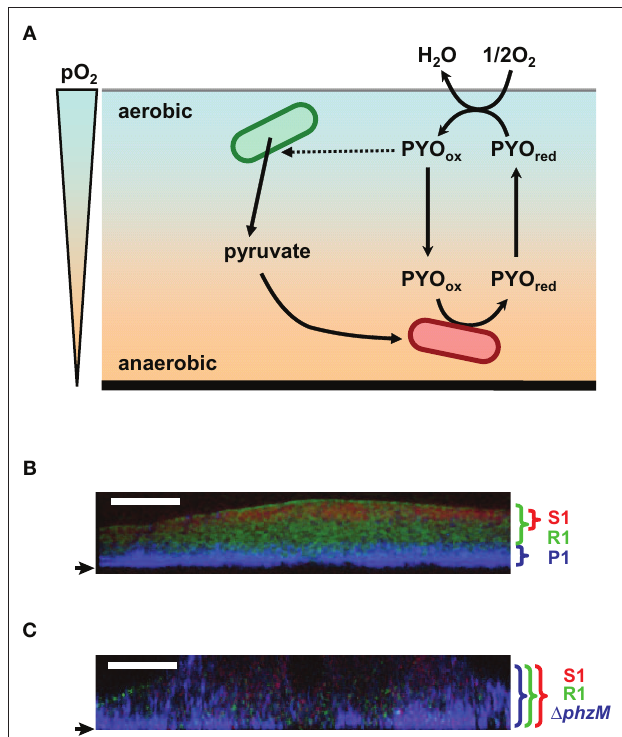
Figure 4 | Hypothetical model of the role of pyocyanin in anaerobic survival in biofilm and construction of the multilayered structure of the multispecies biofilm. (A) Pyocyanin is predicted to act as an electron acceptor for the anaerobic cells and shuttle electrons between anaerobic and aerobic niches. Pyocyanin stimulates excretion of pyruvate. The secreted pyruvate is expected to be utilized for the anaerobic pyruvate fermentation. PYO and PYO indicate the reduced- and oxidized-forms of pyocyanin, red ox respectively. pO indicates partial oxygen pressure. (B,C) FISH images of 2 three-species biofilms in vertical sections. A pyocyanin-overproducing P. aeruginosa strains P1 (P1) and its pyocyanin-non-producing derivative ( ∆ phzM ) appear blue with a Cy3-labeled probe, A pyocyanin-resistant Raoultella strain (R1) and a pyocyanin-sensitive Brevibacillus strain (S1) appear green and red with the FITC- and Cy5-labeled probes, respectively. Strain P1 forms a multilayered biofilm with strains R1 and S1 (B) . An intermingled biofilm is formed when strain ∆ phzM is used (C) . Small arrows indicate the bottom of biofilms. White bars indicate